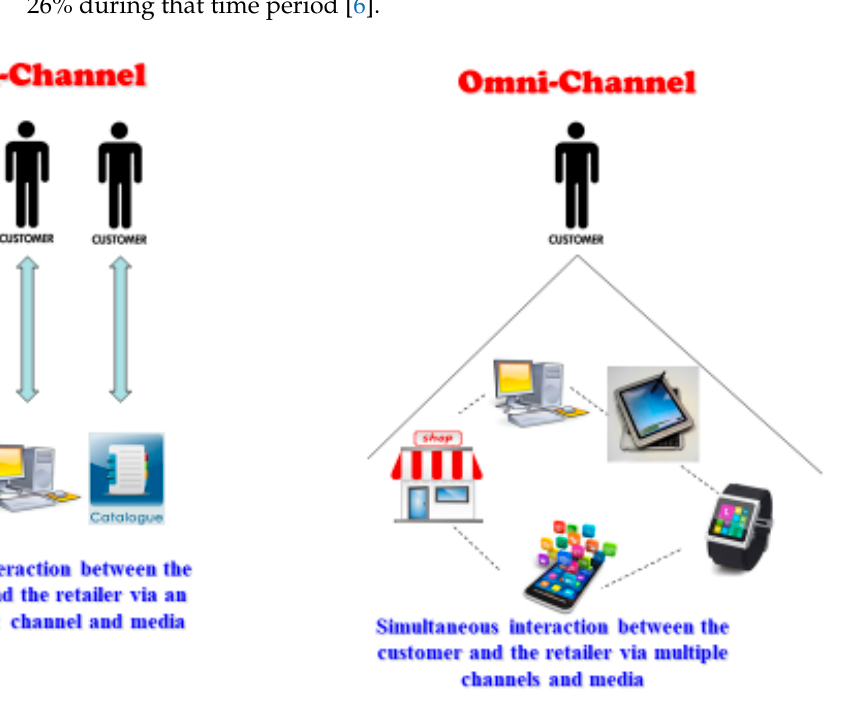
Figure 1. Multi-Channel vs. Omni-Channel. Table 1. Differences between the Multi-Channel and Omni-Channel.